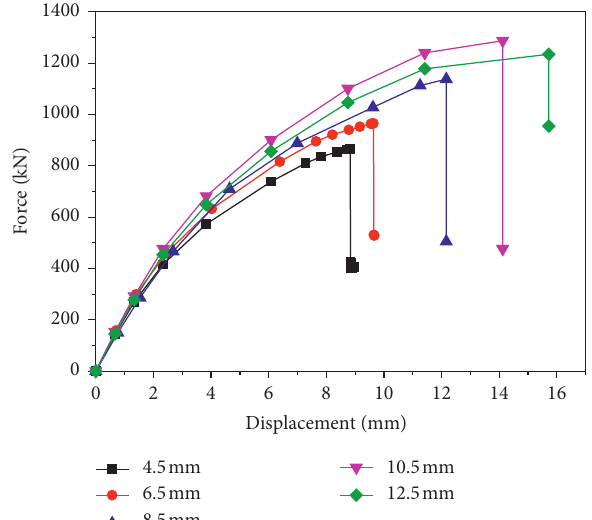
Figure 29: Load-displacement curves of all models.